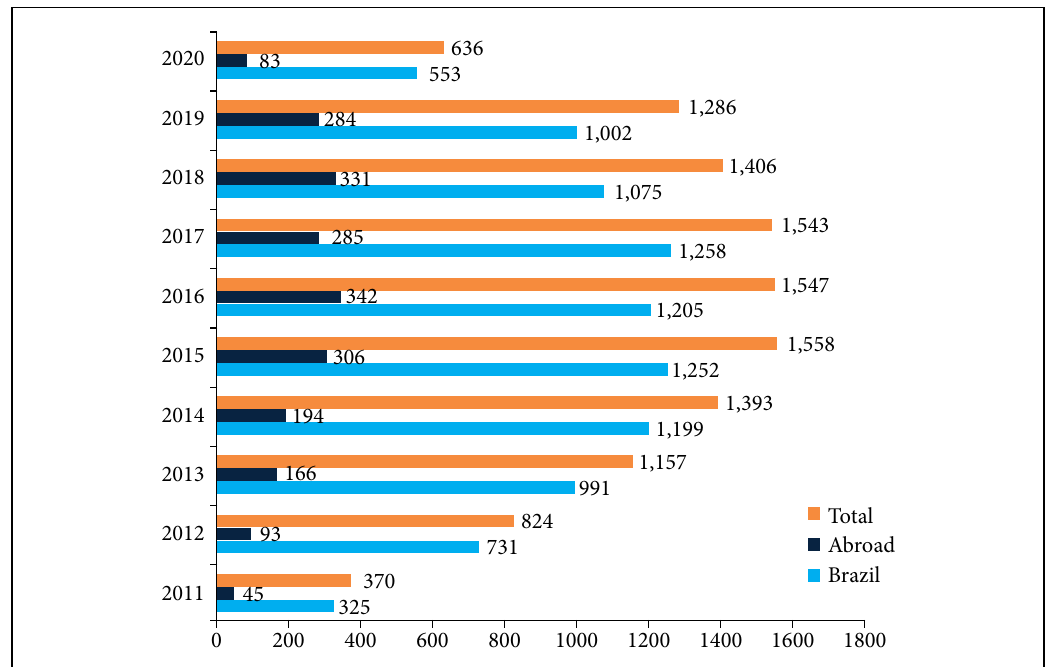
Figure 3 - Comparison of the number of IRCAD courses taught from 2011 to 2020 in Brazil and